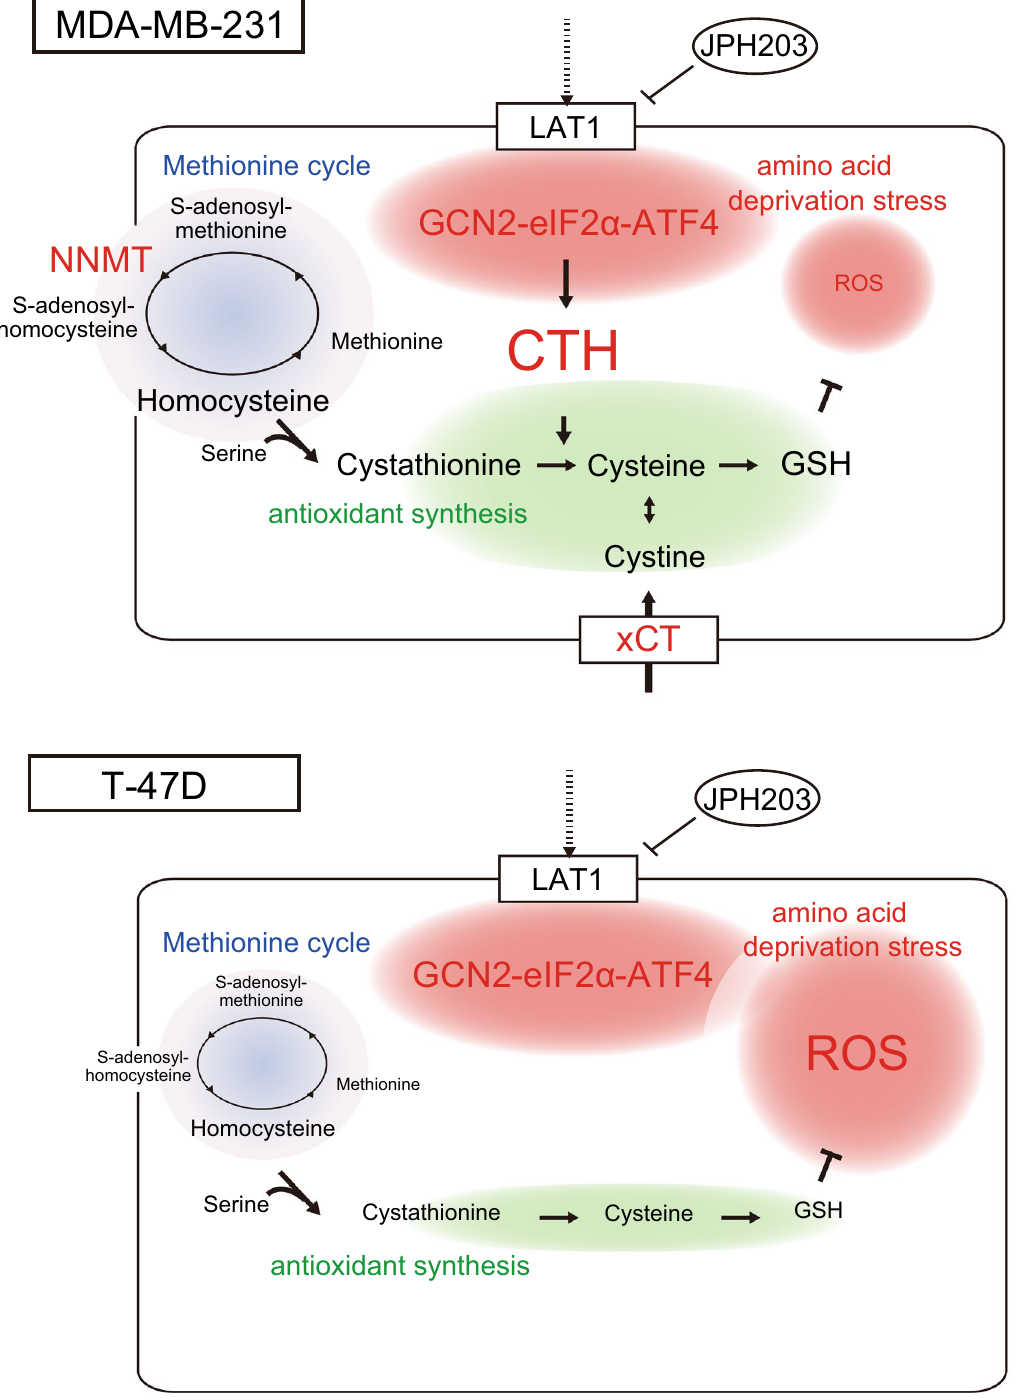
Figure 8. Schematic representation of JPH203-induced amino acid starvation stress pathway in MDA-MB-231 and T-47D